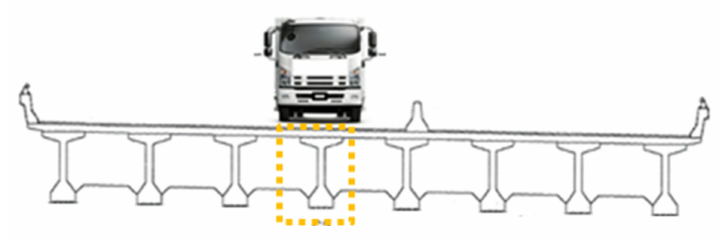
Figure 6. Schematic of the moving vehicle test.